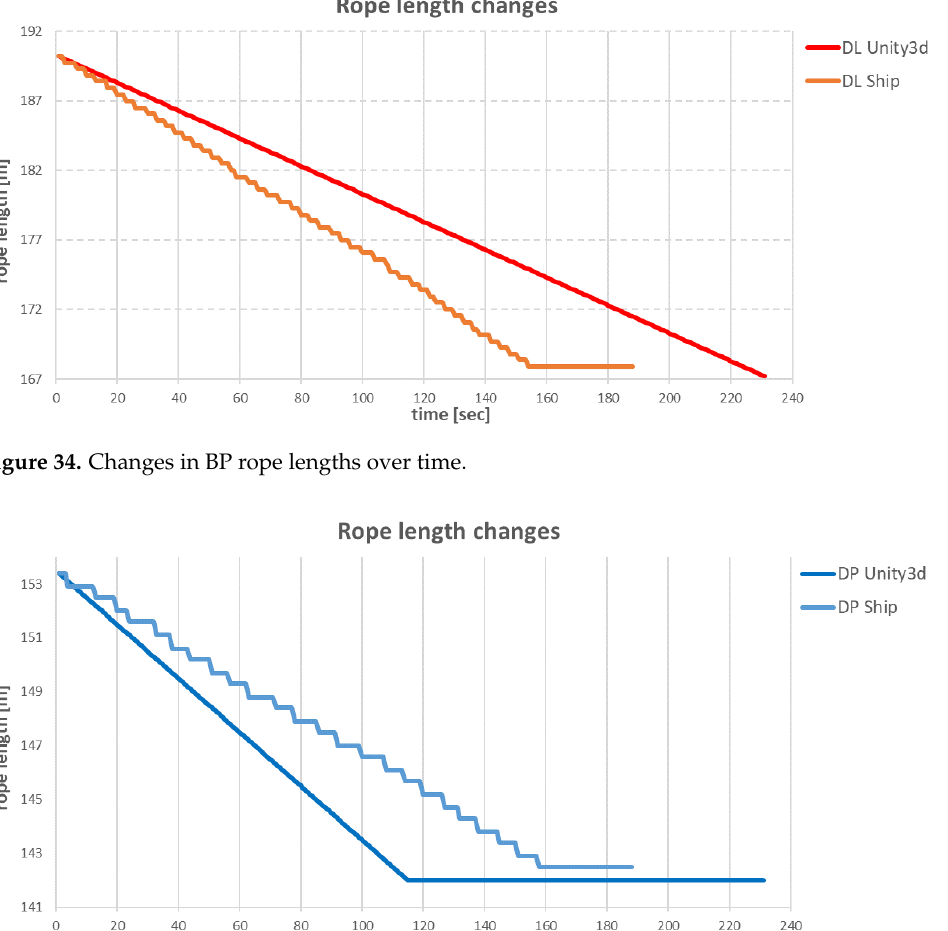
Figure 35. Changes in BS rope lengths over time.